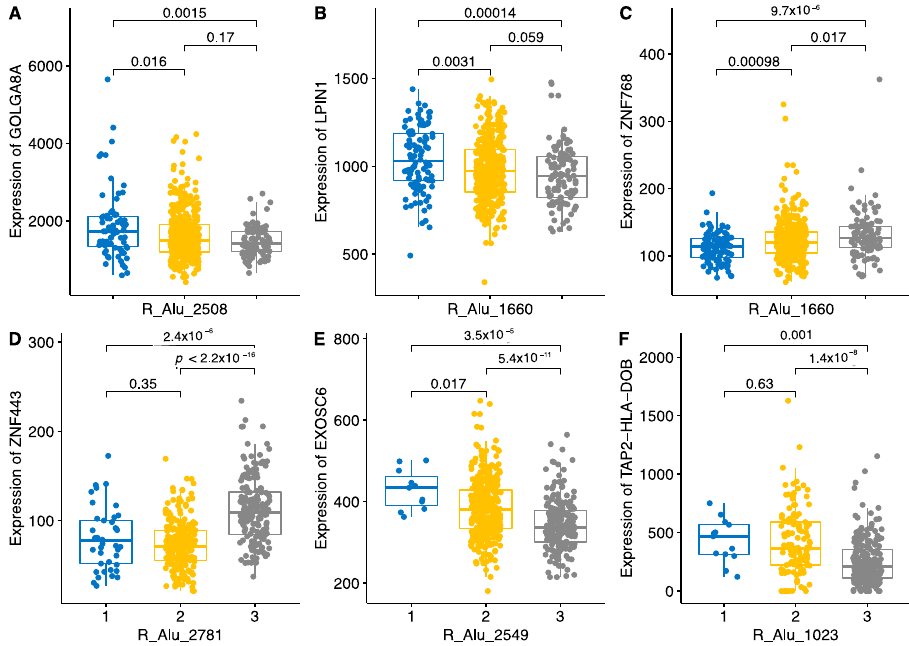
Figure 9. Boxplot of six different genes influenced by Alu repeats. Genotypes of Alus are shown as number 1 for AA, 2 for PA and 3 for PP. Numbers and lines above the bar show p -values of the pairwise comparison. p -values are from the Wilcoxon pairwise comparison. Panels A – F show variable regulation of genes by Alu elements. A, B, E and F show dose-dependent downregulating effect